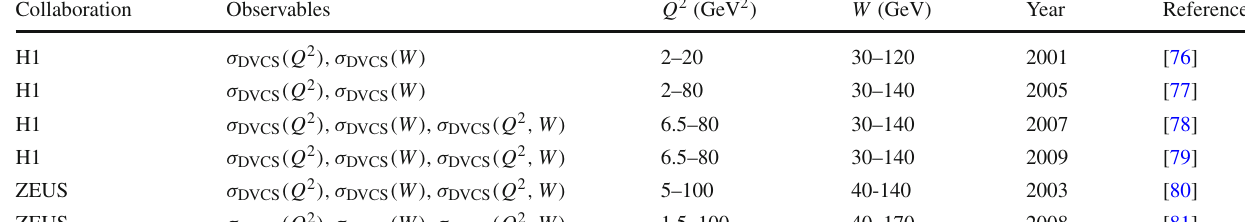
Table1 OverviewofDVCSonprotonexperimentsatHERAcolliderusedinthisstudy.Theobservable σ DVCS isthecrosssectionforthesub-process γ ∗ p → γ p